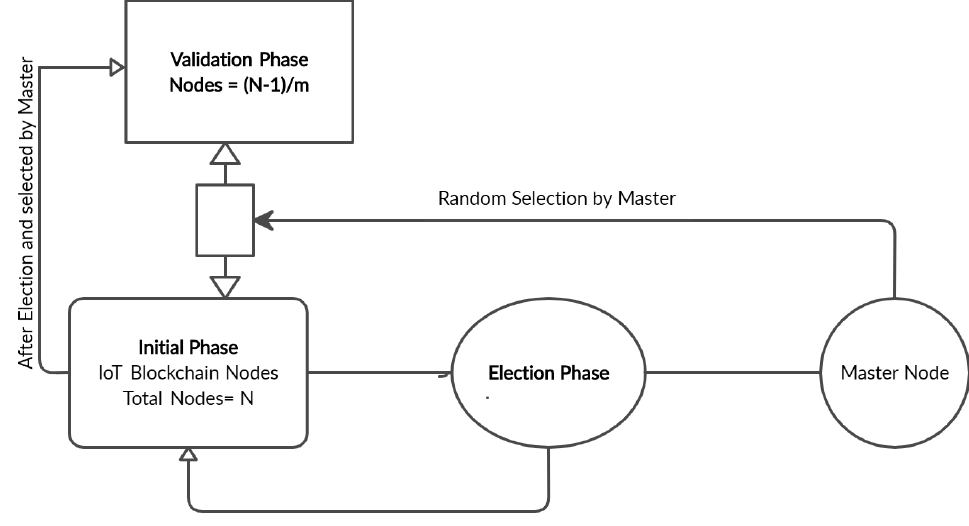
Figure 4. Different phases of BCIoT